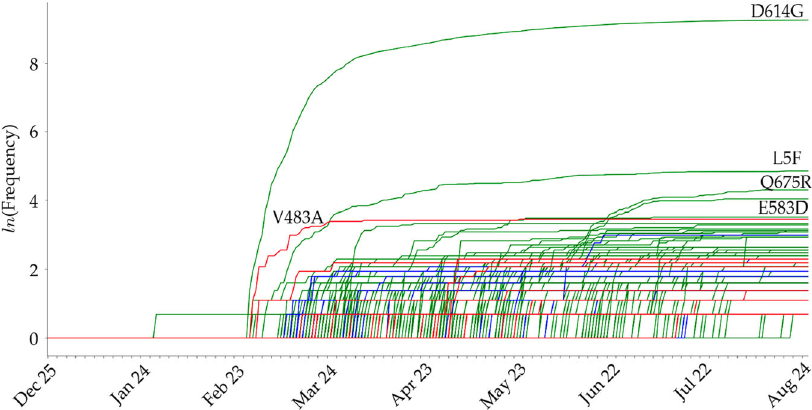
Fig. 6 The time evolution of 264 SARS-CoV-2 S protein mutations. The red lines represent the RBD mutations that strengthen the infectivity of SARS- CoV-2 (i.e., ΔΔ G is positive), the blue lines represent the RBD mutations that weaken the infectivity of SARS-CoV-2 (i.e., ΔΔ G is negative), and the green lines are for S protein mutations that away from the RBD. The mutation with the highest frequency is D614G.